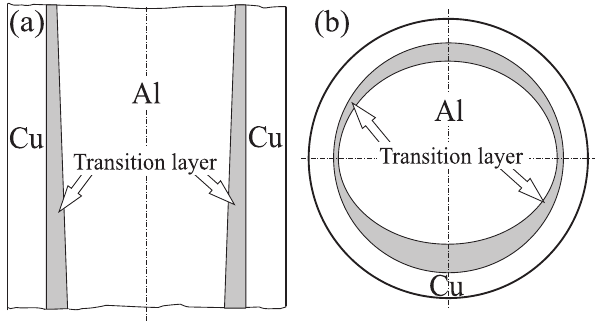
Figure 11: Schematic plan of the transition layer shapes in Cu/Al composite casting: (a) vertical pouring and (b) horizontal